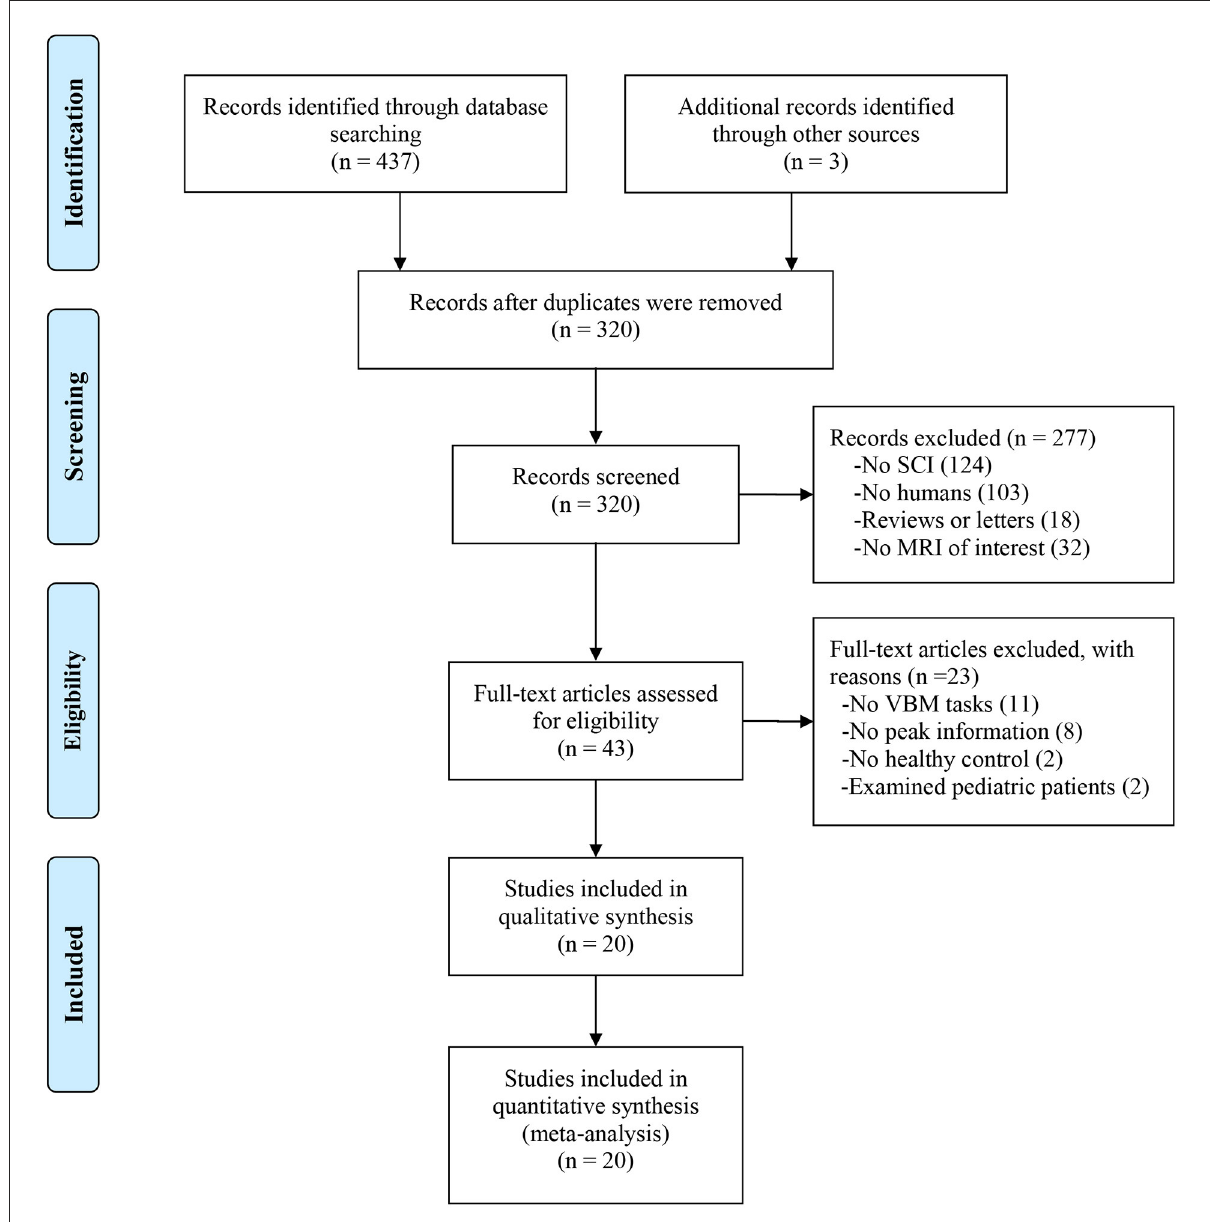
FIGURE1 Flow diagram of inclusion and exclusion process of selected VBM studies. SCI, spinal cord injury; VBM, voxel-based